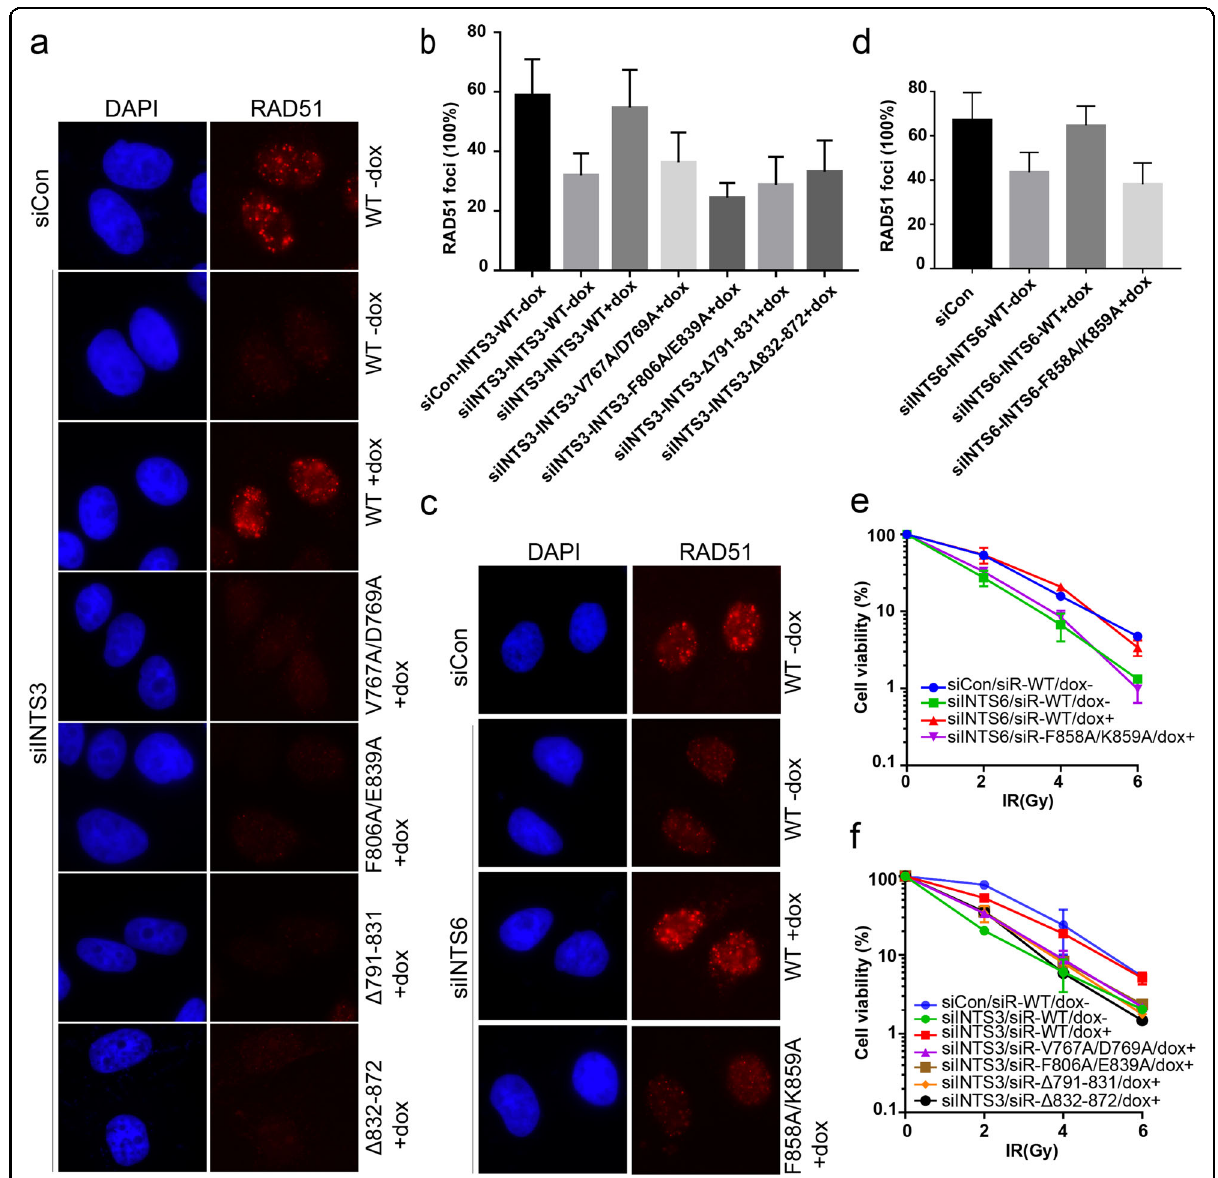
Fig. 4 INTS3 dimerization and its interaction with INTS6 are required for DNA repair. a Cells stably expressing siRNA-resistant wild-type INTS3 or its mutants defective in INTS6 binding (V767A/D769A, F806A/E839A) or the dimer formation ( Δ 791 − 831, Δ 832 − 872) under the control of a tetracycline-inducible promoter were generated. The cell lines were transfected twice with INTS3 siRNA. Twenty-four hours after the second transfection, cells were cultured with doxycycline for 24 h and treated with IR (10 Gy) for 6 h. Cells were then fi xed and processed for RAD51 immuno fl uorescence. b The quanti fi cation of foci-positive cells was performed by counting a total of 300 cells per sample. c Cells that express siRNA- resistant wild-type INTS6 or its point mutant defective in binding to INTS3 (F858A/E859A) under the control of a tetracycline-inducible promoter were generated. The resulting cell lines were transfected twice with INTS6 siRNA. Twenty-four hours after the second transfection, cells were cultured with doxycycline for 24 h and treated with IR (10 Gy) for 6 h. Cells were then fi xed and processed for RAD51 immuno fl uorescence. d The quanti fi cation of foci-positive cells was performed by counting a total of 300 cells per sample. e , f Cells that express siRNA-resistant wild-type INTS3/INTS6 or their mutants under the control of a tetracycline-inducible promoter were generated. The resulting cell lines were transfected twice with control or INTS3/ INTS6 siRNAs. After IR treatment, cells were incubated for 14 days before staining. Experiments were done in triplicates. The results shown are the averages of three independent